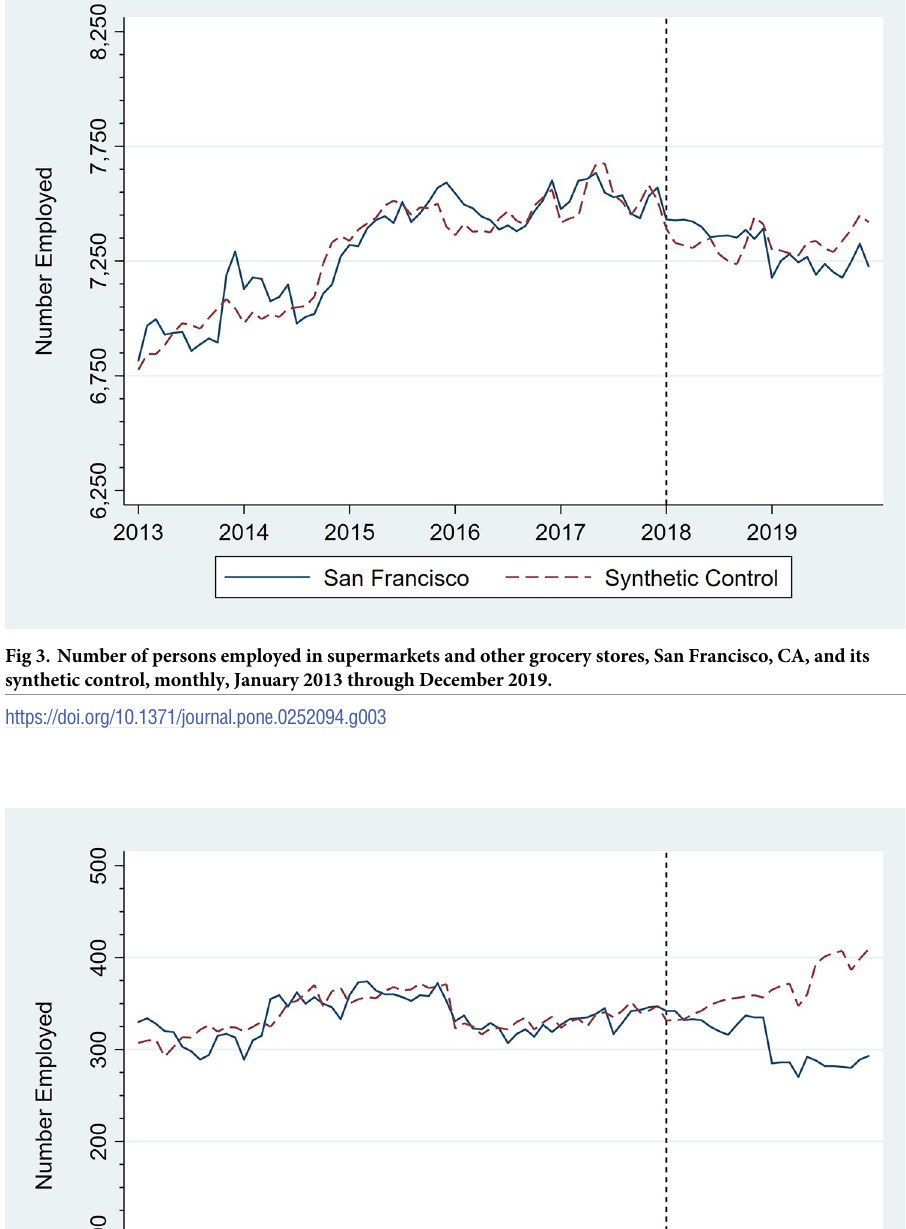
PLOS ONE | https://doi.org/10.1371/journal.pone.0252094 June 2,